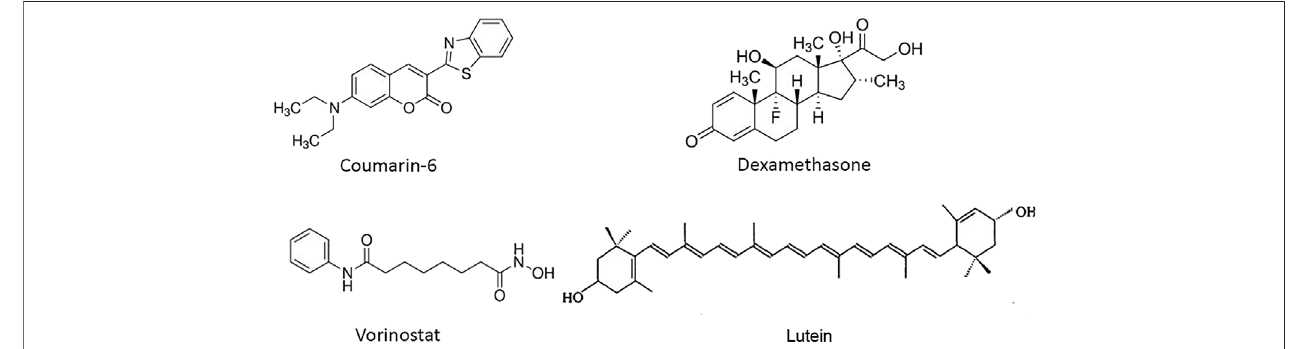
FIGURE 2 | Chemical structures of drugs encapsulated in polymer carriers. (Left to right) Coumarin 6 and dexamethasone (DEX) compounds with steroid structures and several aromatic rings, vorinostat, also known as SAHA and lutein, containing long aliphatic segments.